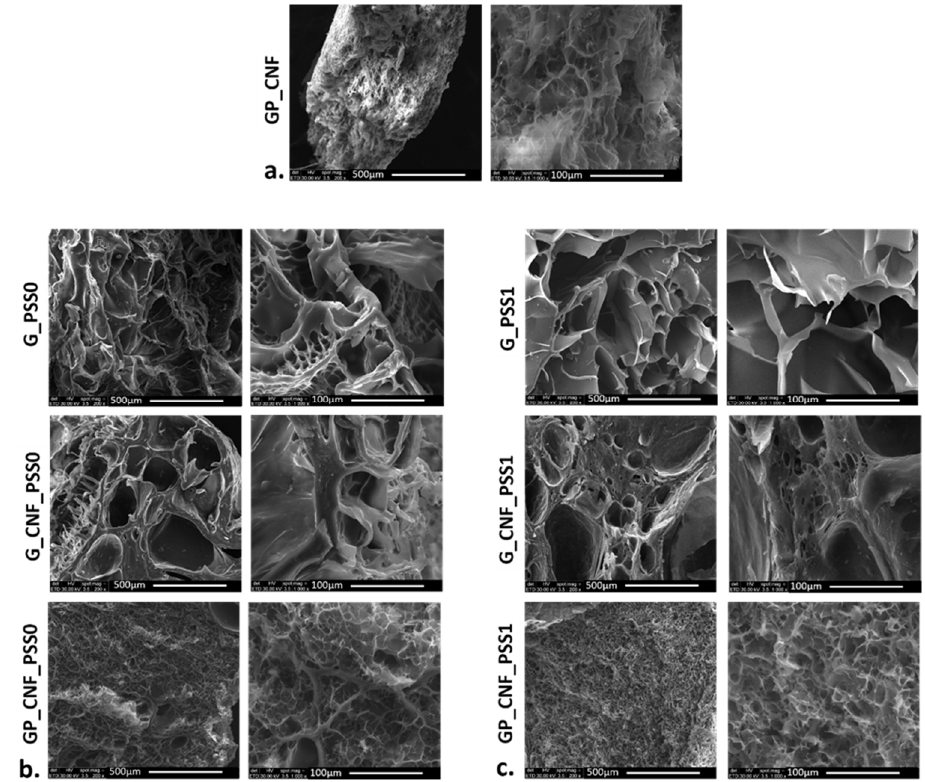
Figure 3. Cross-sectional SEM micrographs showing two different magnifications (200× and 1000×) of the morphology for ( a ) GP_CNF; ( b ) PSS0-enriched; and ( c ) PSS1-enriched scaffolds, respectively, (scale bars 500 μm and 100 μm).